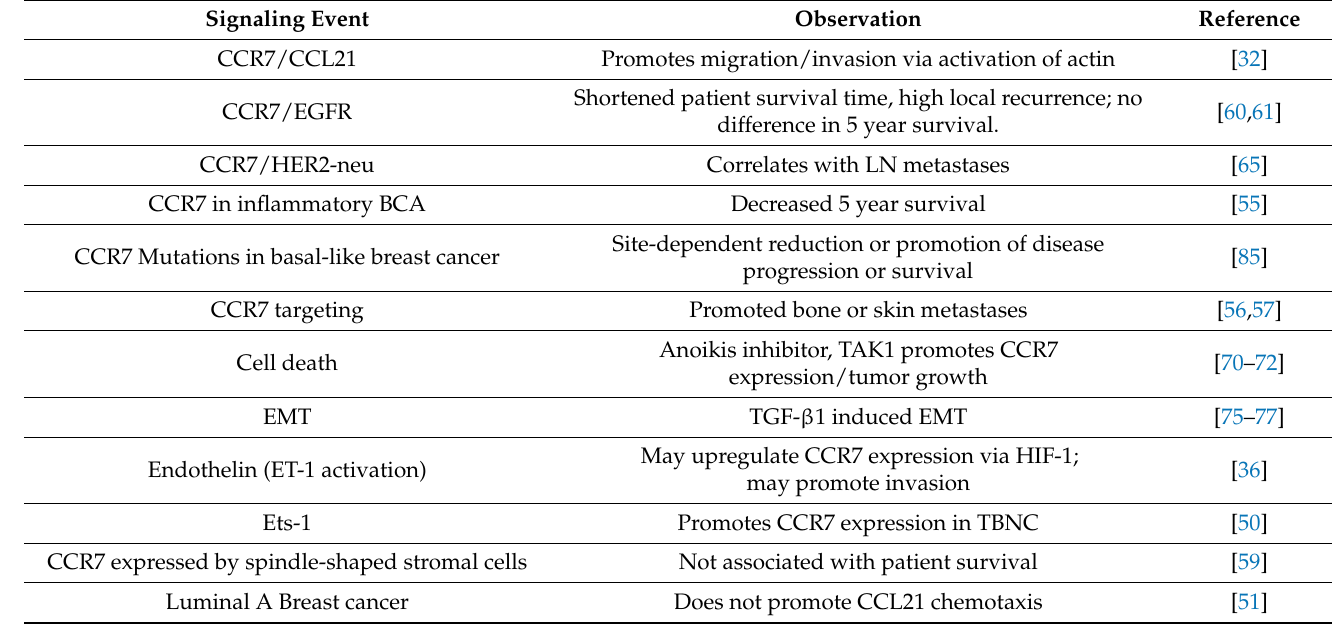
Table 1. Breast cancer and